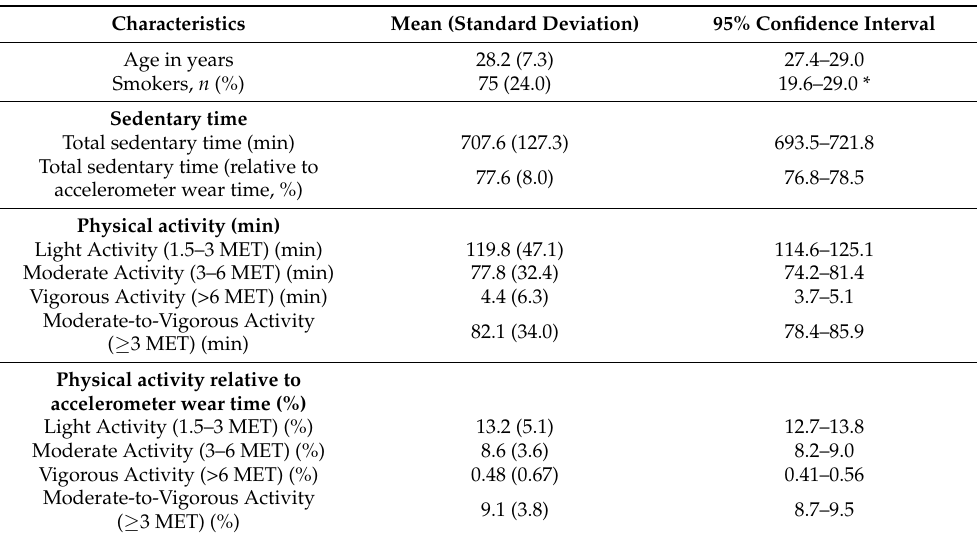
Table 1. Demographic and baseline characteristics of the study population ( n =